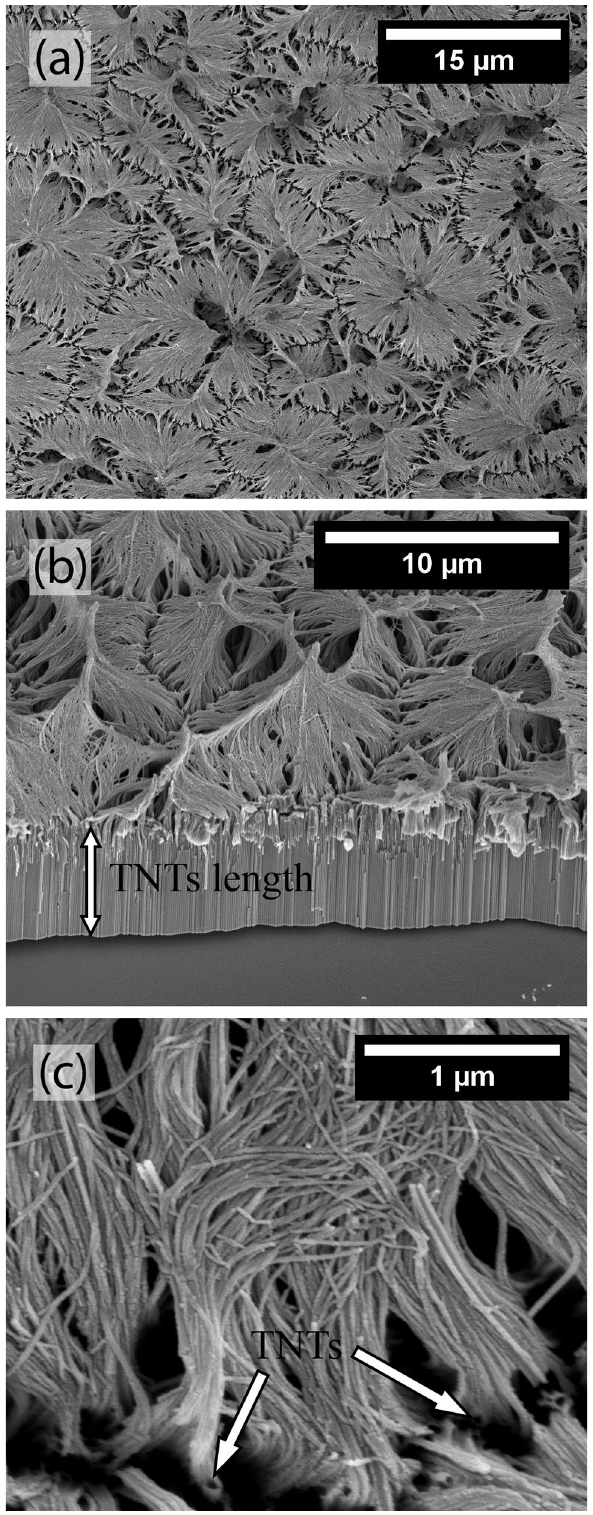
Figure 2. FEG-SEM micrographs of a TNZT sample anodized in the organic electrolyte at 20 V for 12 h, which resulted in the formation of TNWs on top. ( a ) Top-view image, ( b ) angled-view image, and ( c ) top-view image at a higher